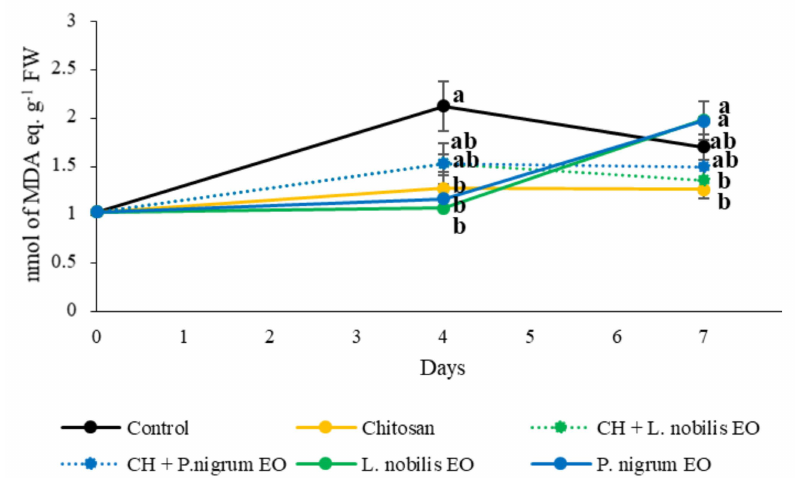
Figure 9. Lipid peroxidation index, expressed as nmol of malondialdehyde (MDA) equivalent g − 1 FW, of beef patties for 7 days of cold storage subjected to different treatments. Chitosan (CH); Laurus nobilis or Piper nigrum essential oil (EO); EOs-enriched CH solutions (CH + L. nobilis EO; CH + P. nigrum EO). Data are expressed as mean ± standard error. Different letters (a,b) indicate significant differences among treatments (Tukey HSD, p ≤ 0.05) for each